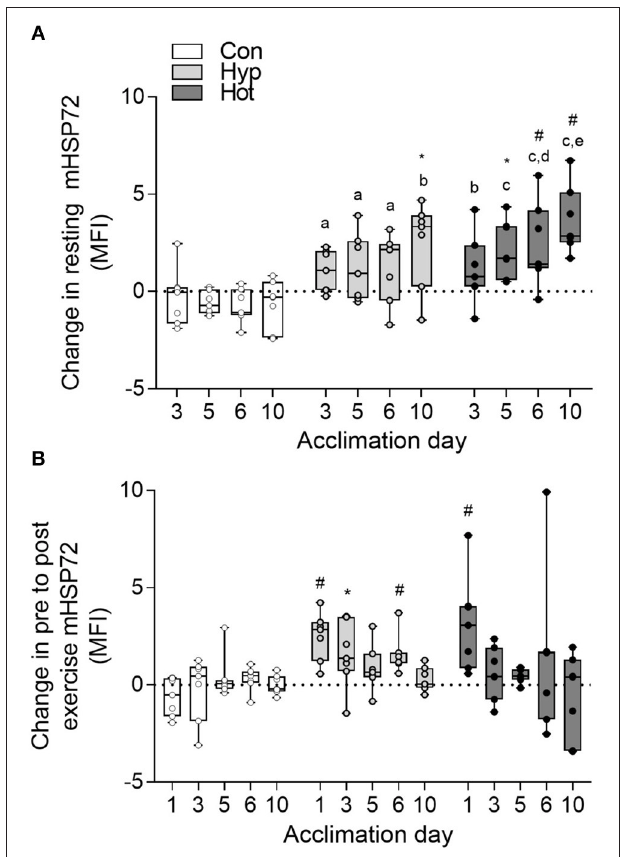
FIGURE 2 | Delta change in resting monocyte HSP72 MFI relative to the resting value obtained on day 1 of acclimation (A) ; and delta change in pre to post-exercise mHSP72 MFI relative to daily resting mHSP72 MFI (B) . Box plots show all individual data points (dots), the 25 and 75th interquartile ranges (boxes), and the median (mid-line). Whiskers illustrate the highest and lowest value. Letters illustrate changes from the resting mHSP72 value obtained on